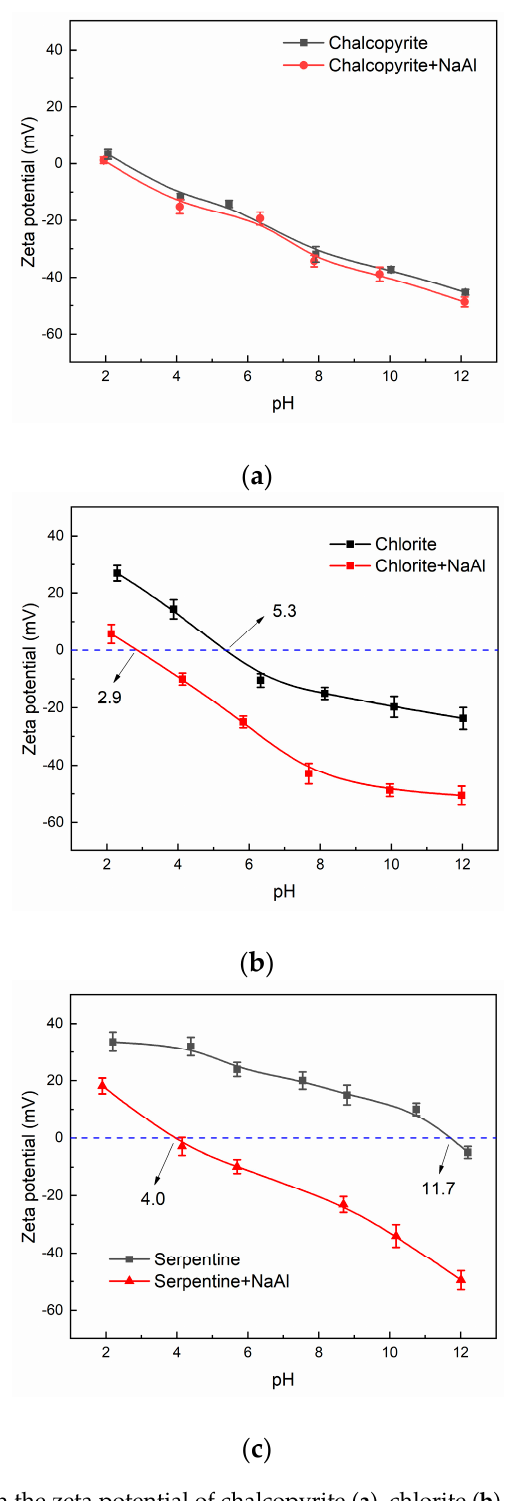
Figure 7. Effect of pH on the zeta potential of chalcopyrite ( a ), chlorite ( b ), and serpentine ( c ) in the absence and presence of NaAl. [NaAl] = 80 mg/L.